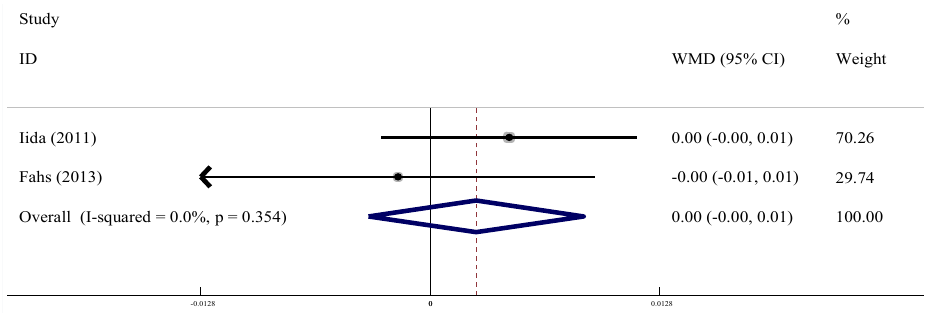
Figure 14. Meta-analysis of the effect of LL-BFR training on VC in the older adults.